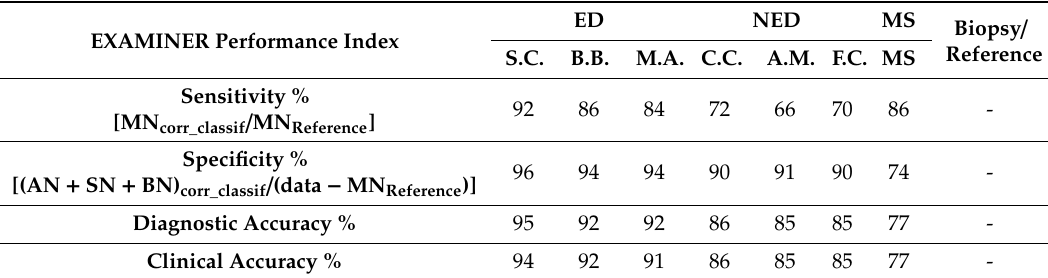
Table 6. Performance of comparison of lesion classification results by expert (ED) / non-expert (NED) dermatologist groups and automatic measurement system